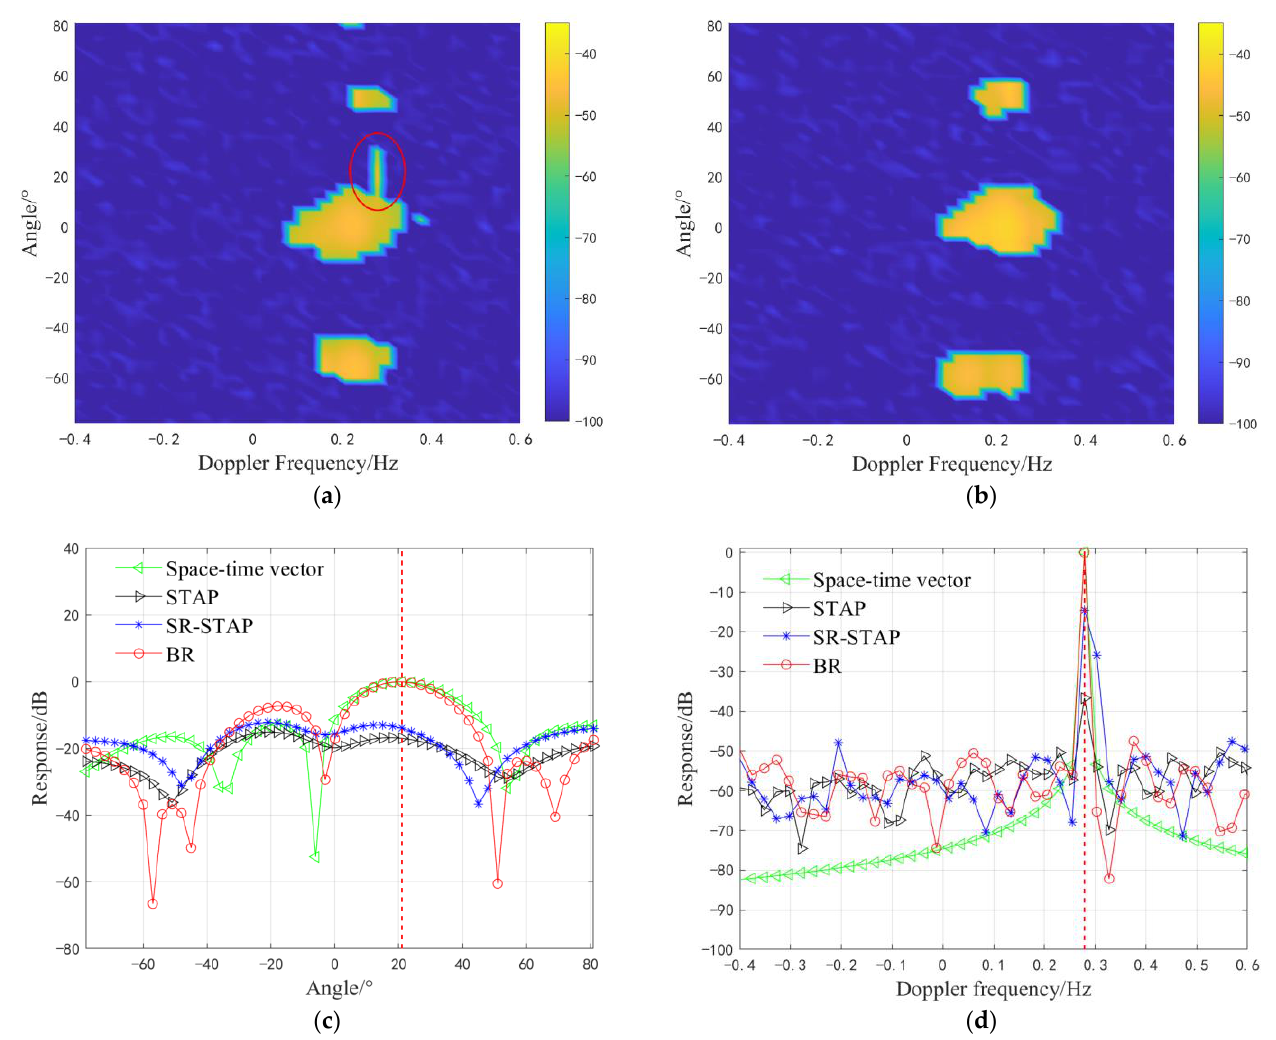
Figure 6. ( a , b ) Angle–Doppler maps of the No. 94 and No. 95 range bins after sparse representation. Comparison of response patterns for the weight vector in ( c ) the angle domain and ( d ) Doppler frequency domain for different algorithms for the measured data.